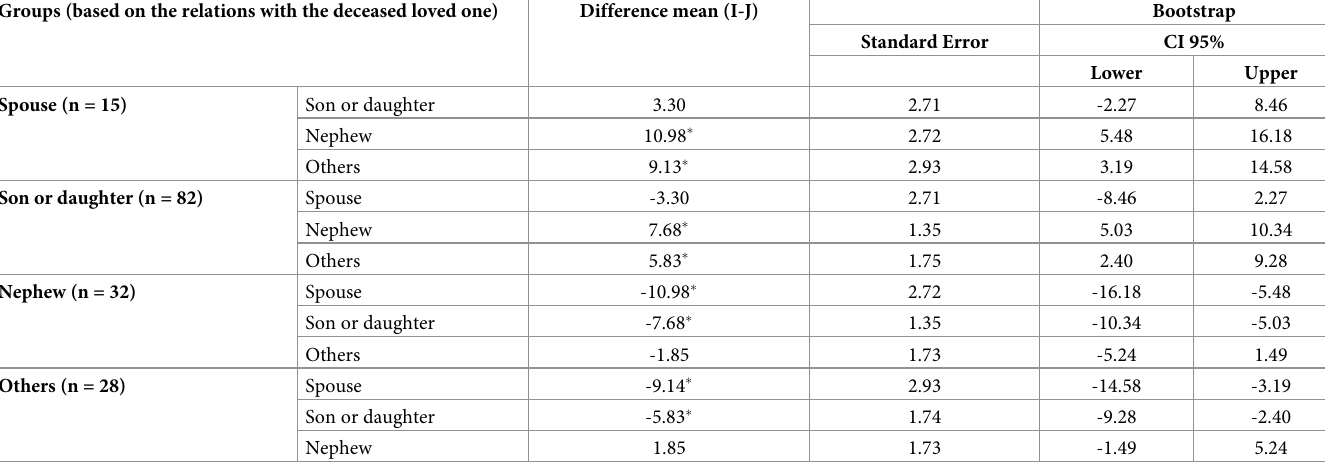
Table 2. Games-Howell post-hoc test for intensity of prolonged grief symptoms based on the deceased loved one ( N = 157). Groups (based on the relations with the deceased loved one)